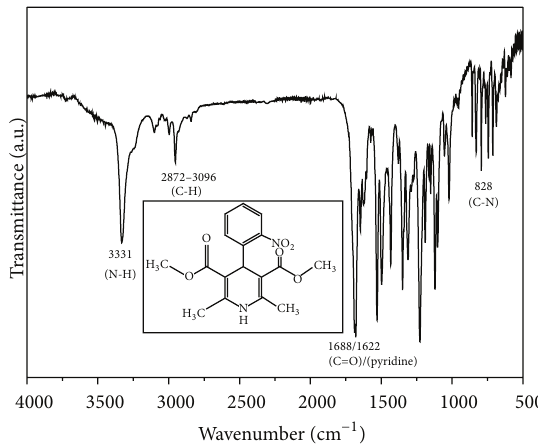
Figure 5: FTIR spectrum of pristine nifedipine.